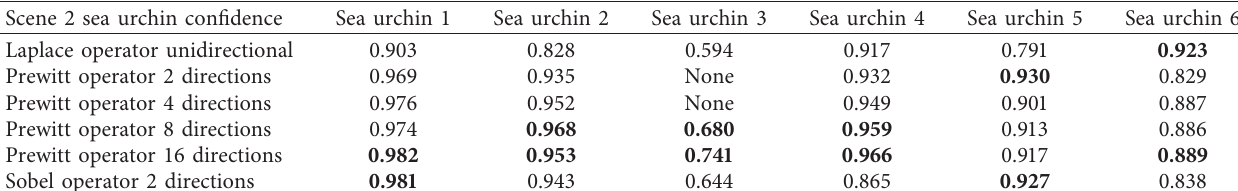
Table 4: Sea urchin confidence in the ISSD algorithm for multidirectional detection in Figure 10(a). Scene 2 sea urchin